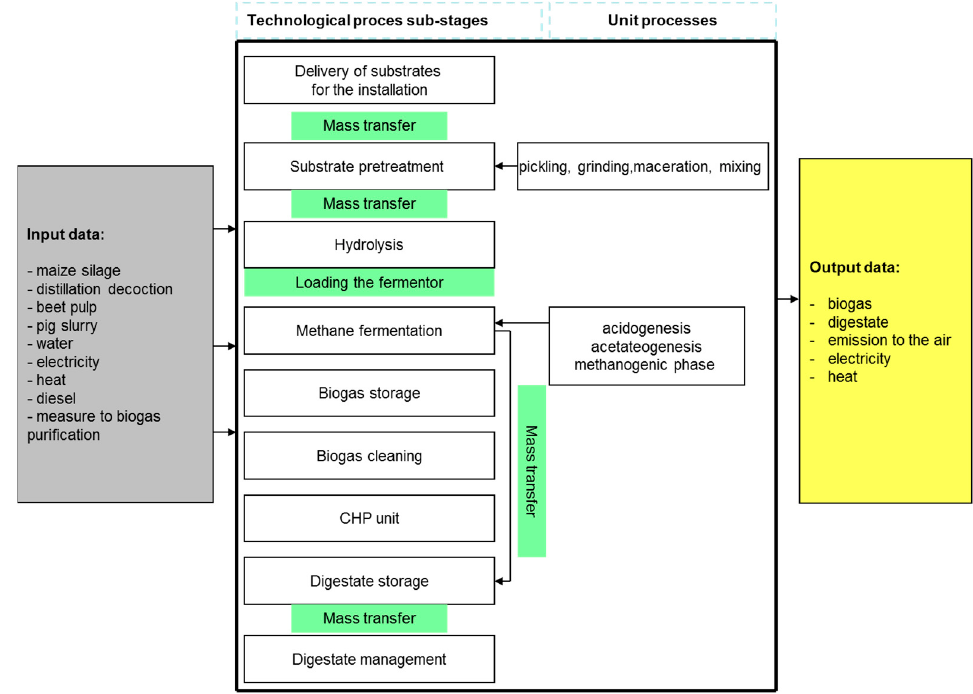
Figure 4. General scheme of sub-steps in the technological process of biogas production.